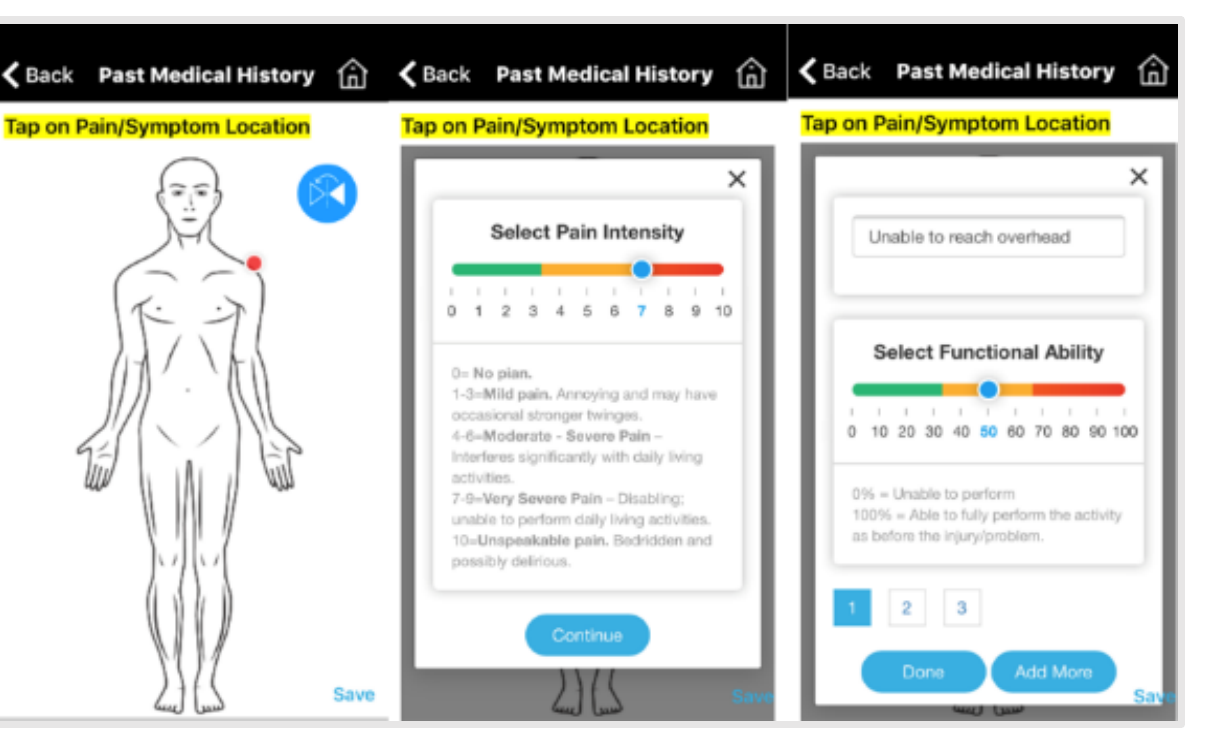
Figure 1. From left to right: Body Pain Diagram (BPD), Numeric Rating Scale (NRS), and Patient Specific Functional Scale.